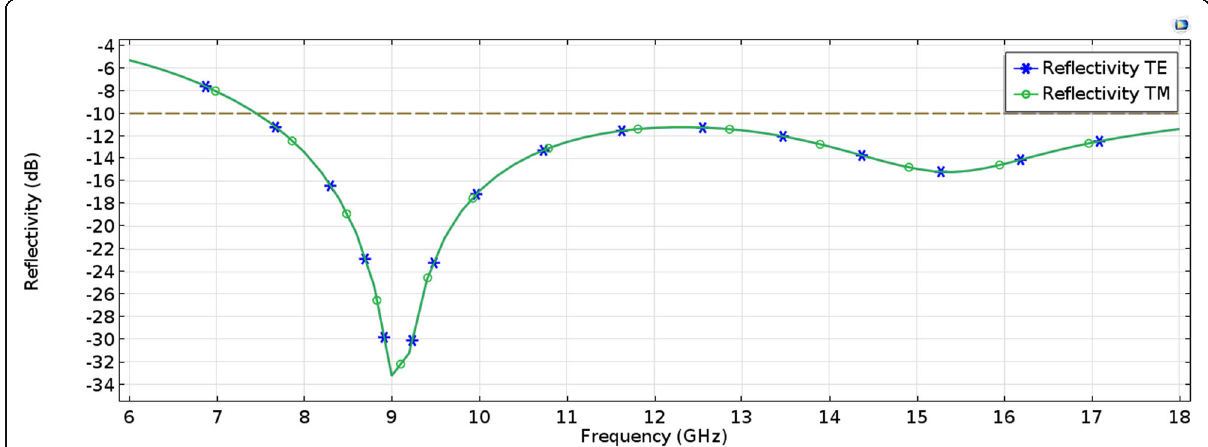
Fig. 8 Simulated reflectivity plots of the optimized structure at normal incidence for TE and TM